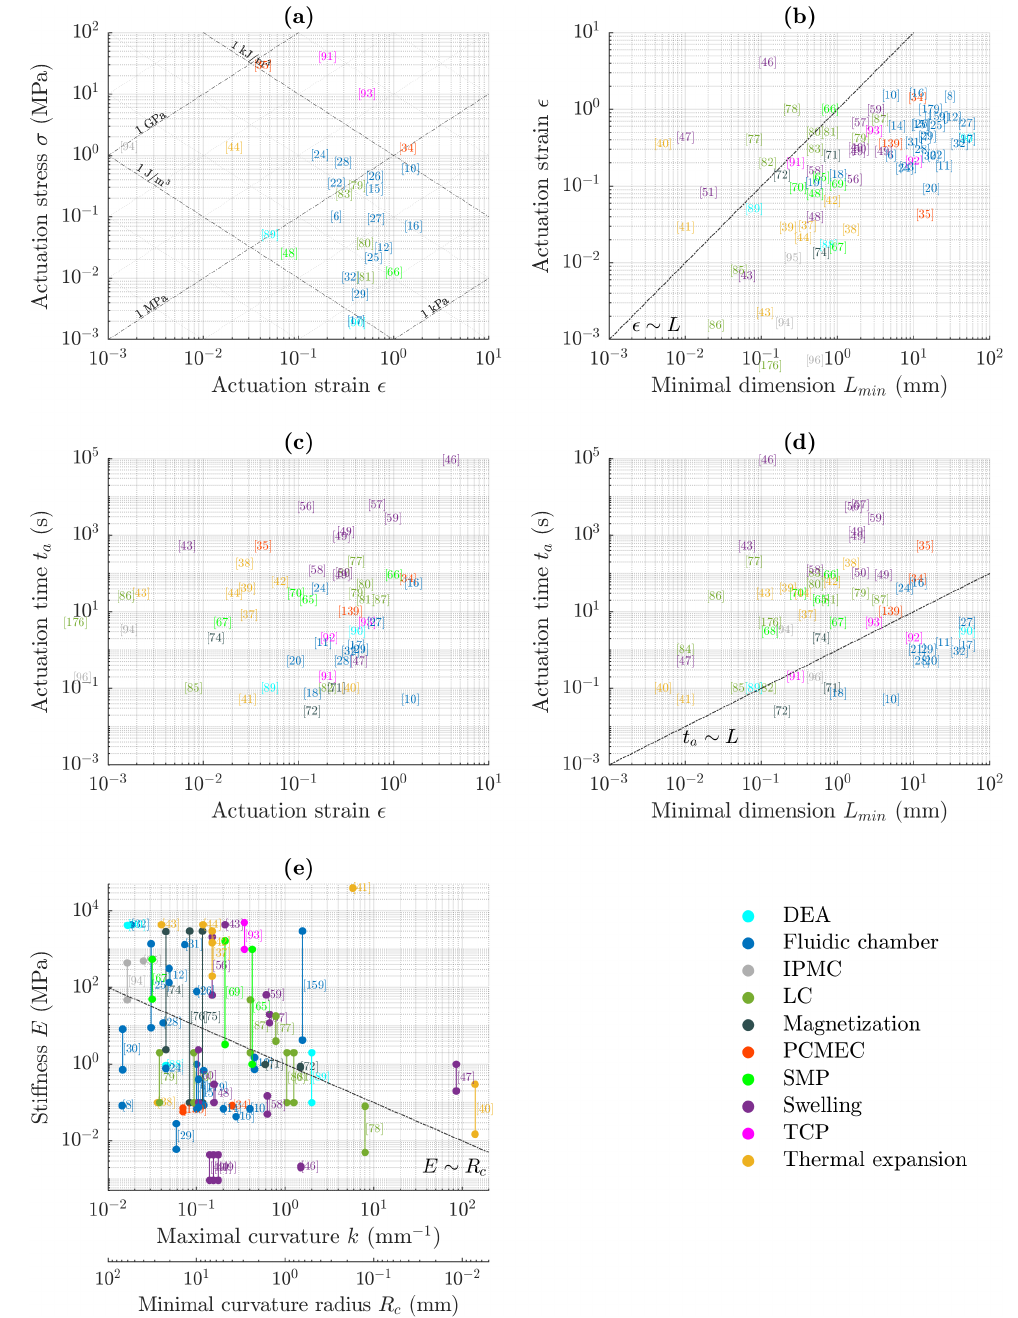
Figure A1. Comparison of the different actuators performances, with corresponding references. The colors represent the type of transducer. ( a ) Actuation stress as a function of the actuation strain. The diagonal lines of positive slope represent a constant value of σ / (cid:101) , which is a characterization of the stiffness of the actuator. The diagonal lines of negative slope σ(cid:101) are lines of constant energy density. ( b ) Actuation strain as a function of the minimal dimension. The dashed line has a slope of 1 ( (cid:101) ∼ L ). ( c ) Actuation time as a function of the actuation strain. ( d ) Actuation time as a function of the minimal dimension. The dashed line has a slope of 1 ( t a ∼ L ). ( e ) Stiffness as a function of the curvature. The same figure without the references is presented and discussed in Figure 8 and a similar figure comparing the different extrinsic asymmetries is presented in Figure